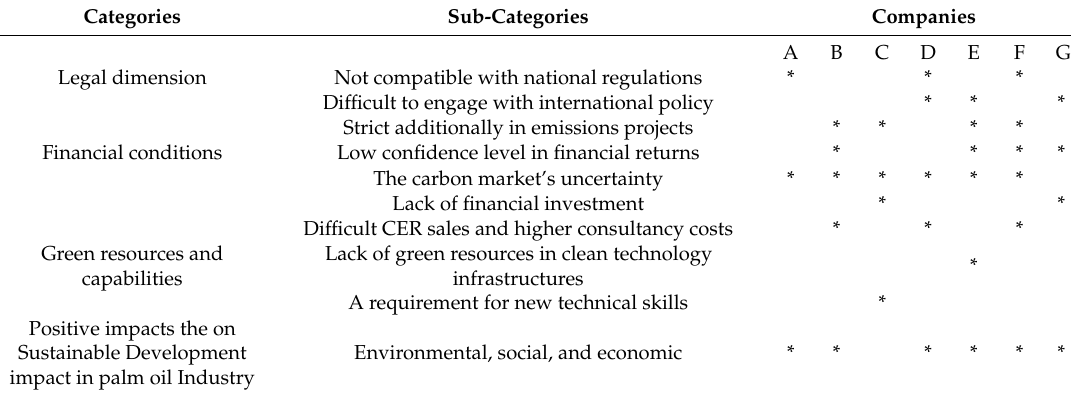
Table 5. Interview findings on crucial factors and positive sustainable development